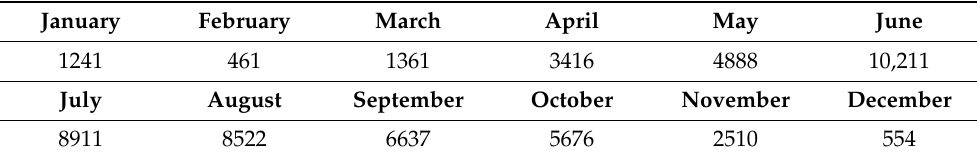
Table 7. Forecasting results for 12 periods in 2021 by Holt’s exponential smoothing method with smoothing outliers.